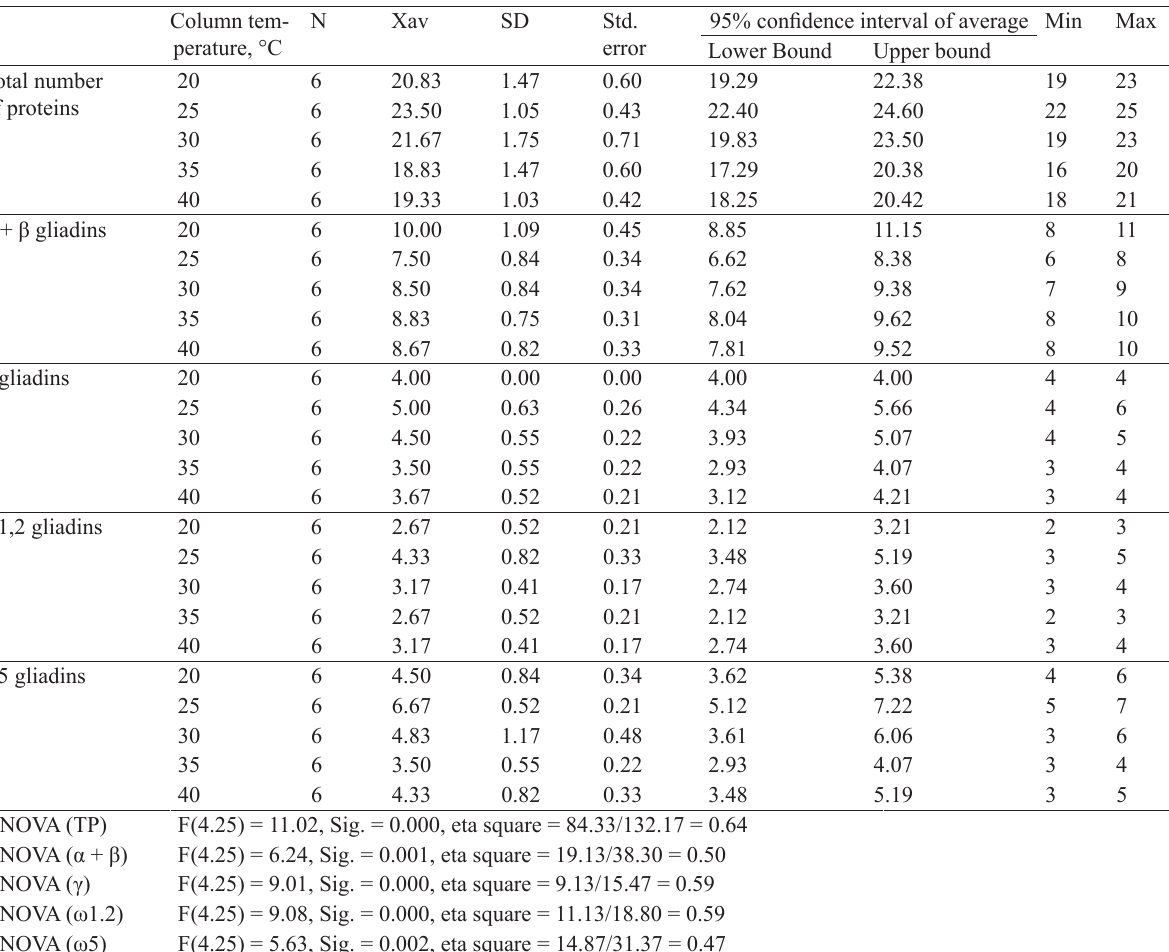
Table 4 Descriptive indicators of total proteins and the number of gliadin fractions (70% ethanol, Agilent, CE 7100, capillary inside diameter 50 µm, total capillary length 33 cm, effective capillary length 23.50 cm, voltage –16.5 kV (reverse mode),